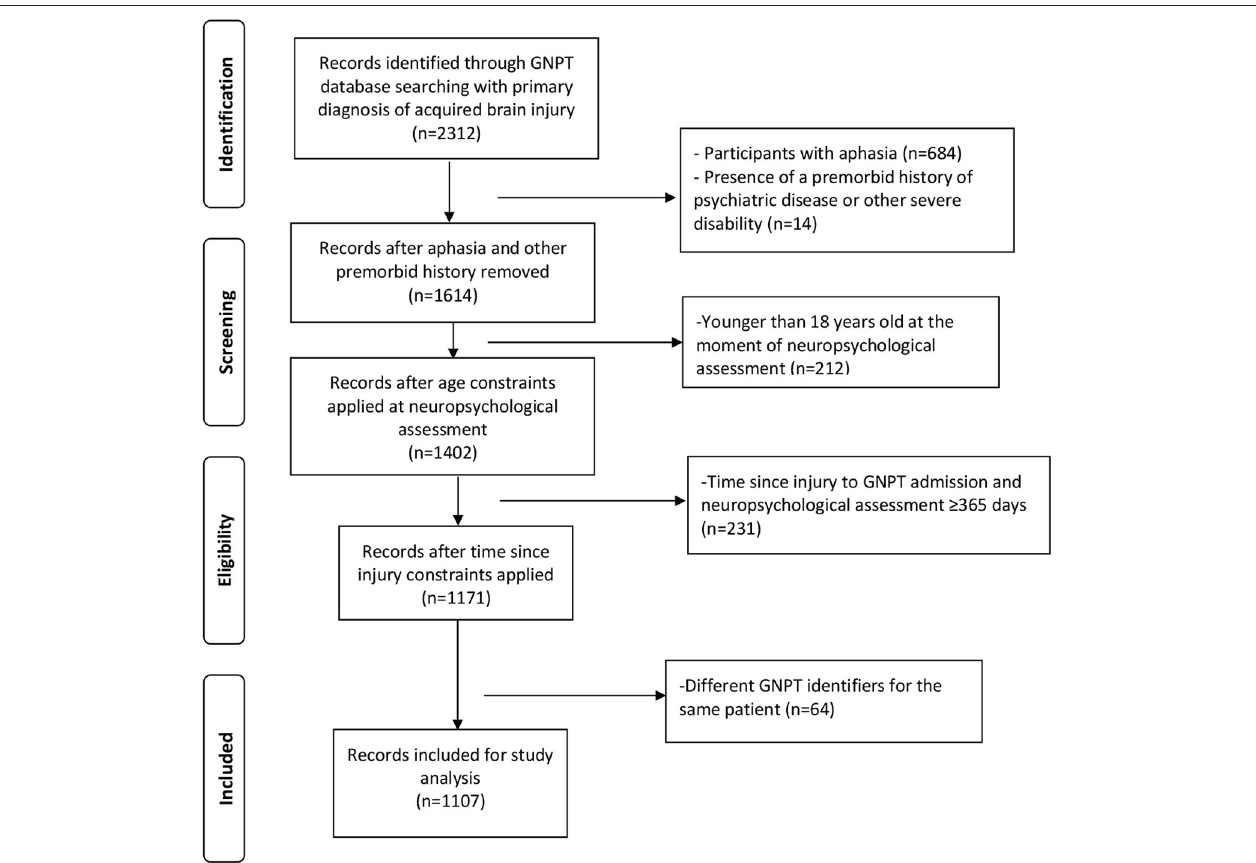
FIGURE 1 | Participants’ selection